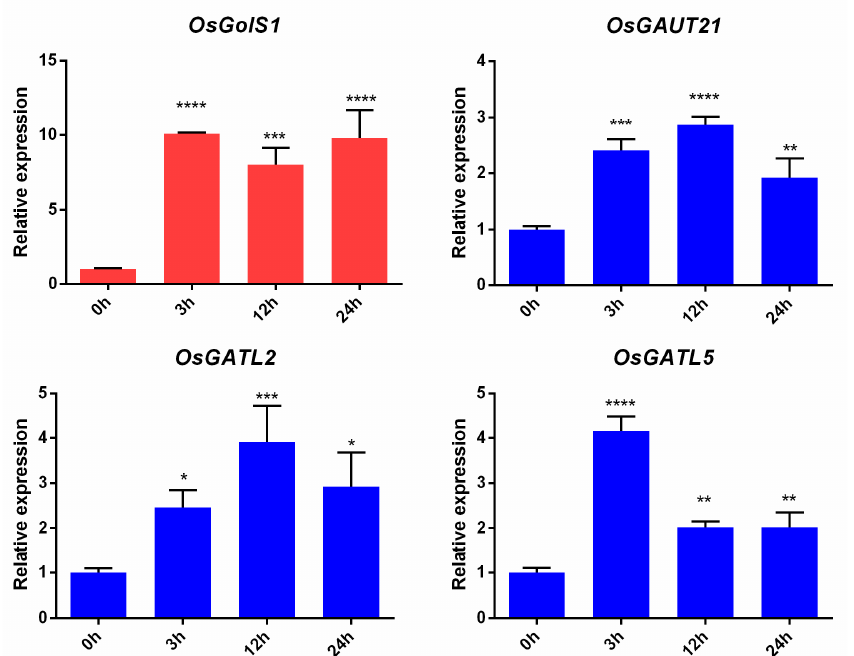
Figure 7. The qRT-PCR of the salt/cold-responsive GT8 genes in ‘Nipponbare’ seedling leaf after NaCl treatment / Cold (4 °C) treatment for 0 h, 3 h, 12 h, and 24 h. Red indicates salt stress and blue indicates cold stress. The fold changes of these genes were calculated by 2 −ΔΔ CT method from three biological replicates. The bars show the standard deviations of three biological replicates and * represents a significant difference relative to the 0 h group (* p < 0.05, ** p < 0.01, *** p < 0.001, **** p < 0.0001).